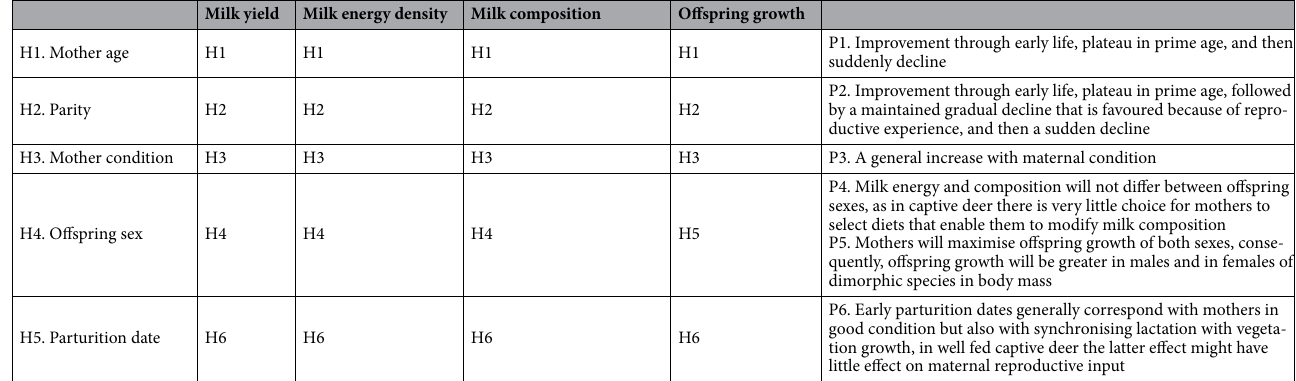
Table 1. Hypotheses on the effect of maternal age (H1), maternal allocation history (parity) (H2), maternal condition (H3) and differential input allocation (H4-5) and parturition date (H6) and predictions (P1–P6) on maternal reproductive life history traits (milk yield, milk energy density, milk composition and offspring growth) in captive Iberian red